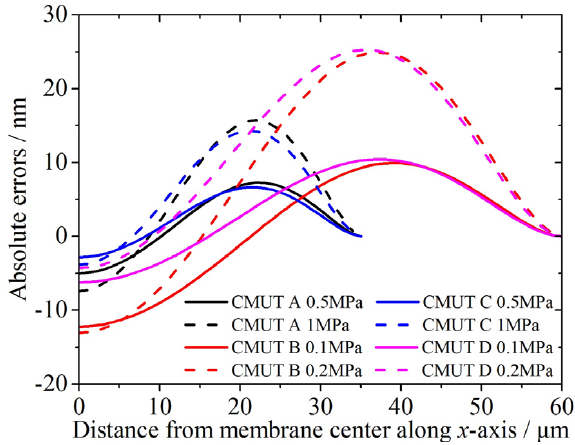
Figure 5. The absolute errors of the static deflection profiles of the three-layer CMUT membranes in relation to FEM simulations.